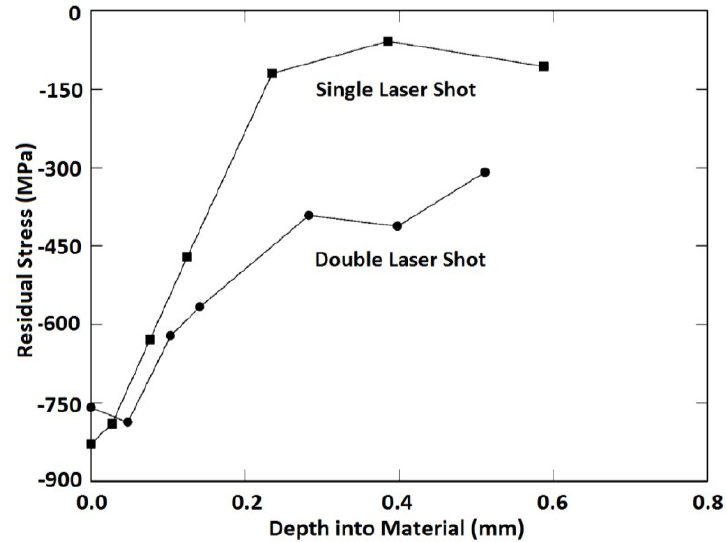
Figure 6. The depth of compressive stresses induced by single and double successive laser shocks on Ti-6Al-4V [99].